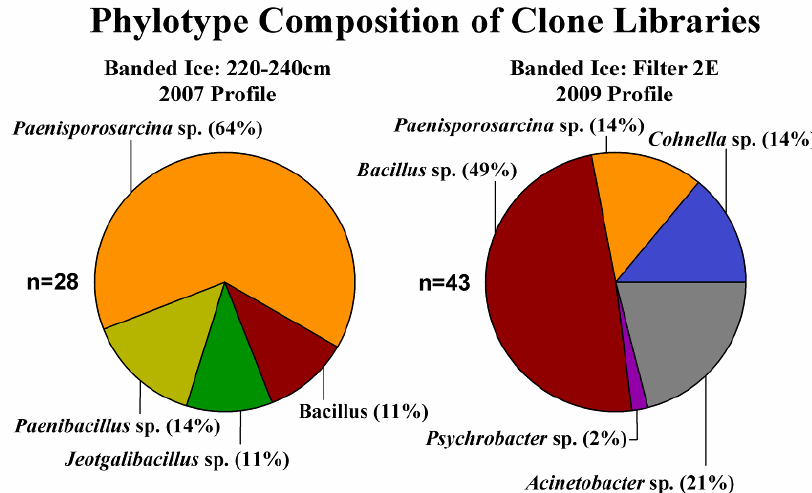
Figure 3. Taxonomic classification of partial 16S rRNA gene sequences amplified and cloned from the Taylor Glacier banded ice. Phylogenetic assignments were performed after 100 iterations using the naive Bayesian classifier [43] in MOTHUR with the SILVA database as a